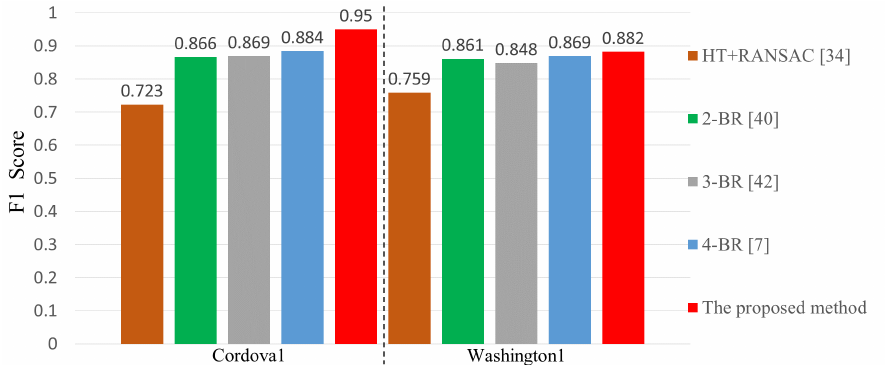
Figure 12. Comparison of neural-network-based methods and the proposed